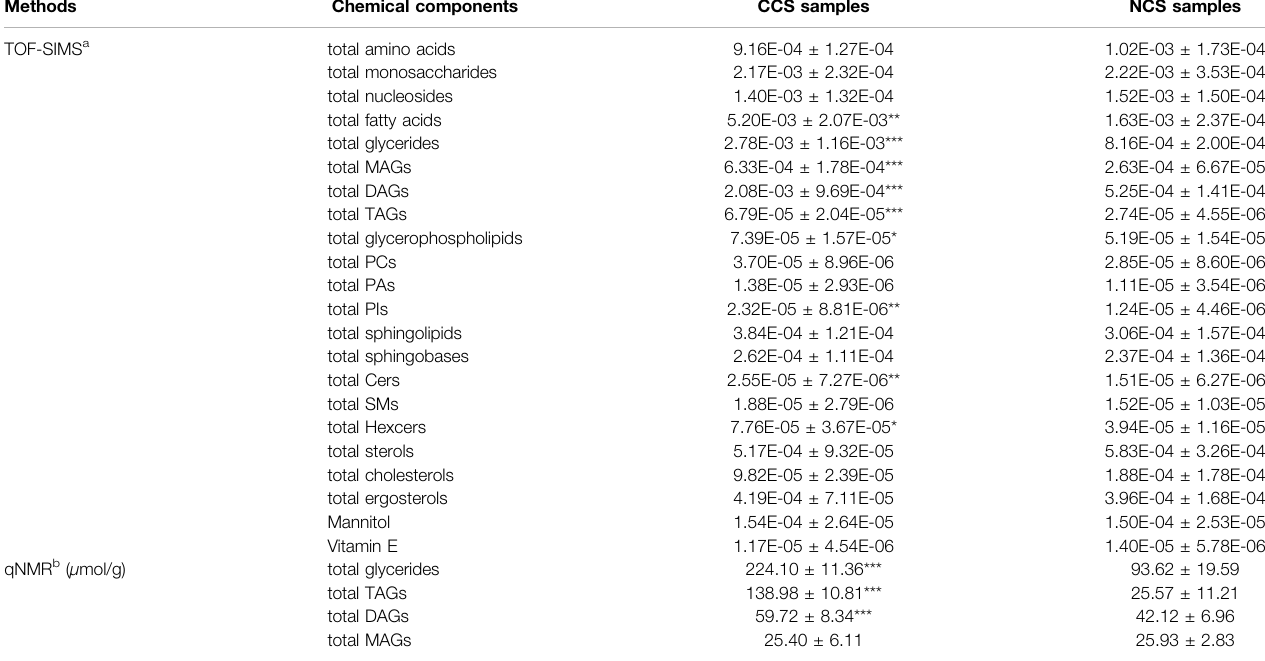
TABLE 2 | The amounts of various types of components in CCS and NCS samples by TOF-SIMS and